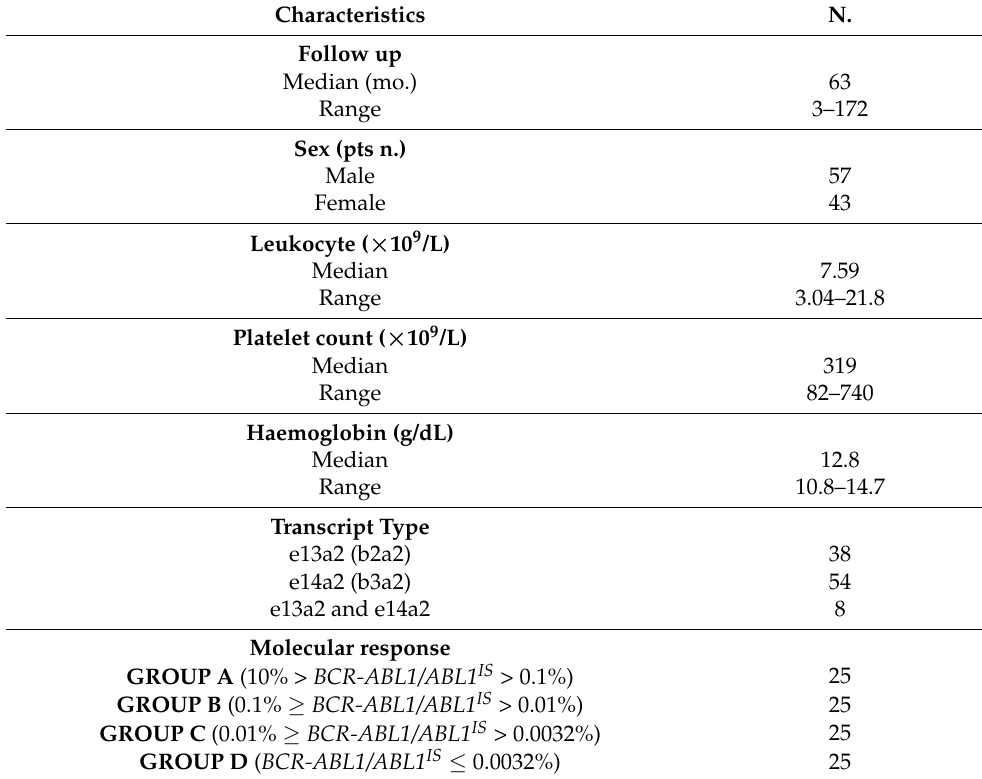
Table 1. Patient Characteristics (N =